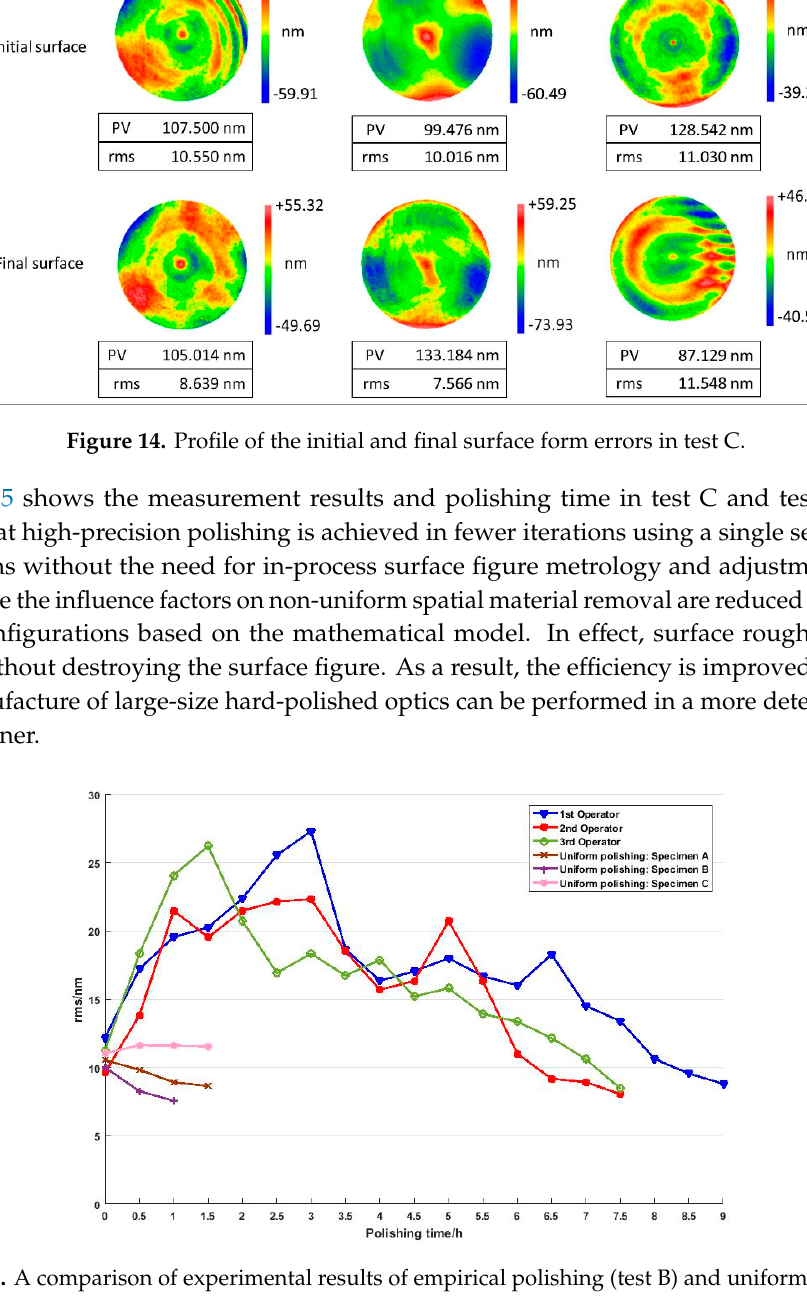
Table 4. Uniform polishing parameters.